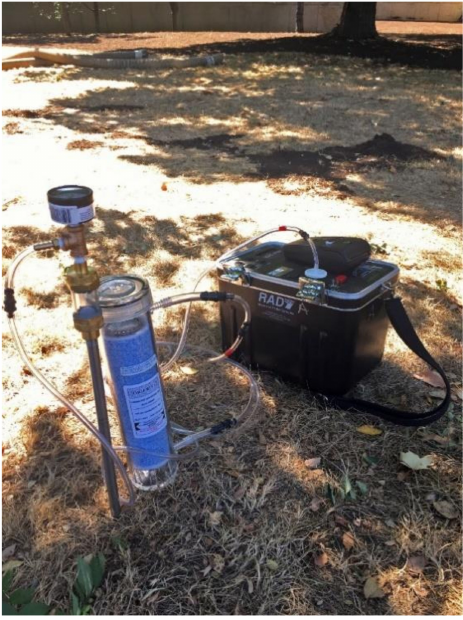
Figure 1. RAD7 soil gas testing